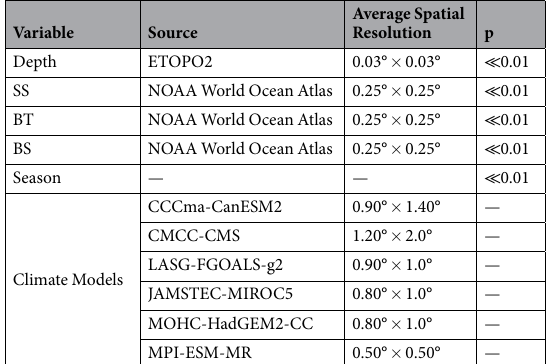
— Table 1. Variables used to predict density in final generalized additive model. Model was trained using samples from NOAA surveys, and predictor variables used downscaled climate models. P-values are the result of a Wald test determining if smoothed model parameters are significantly different than